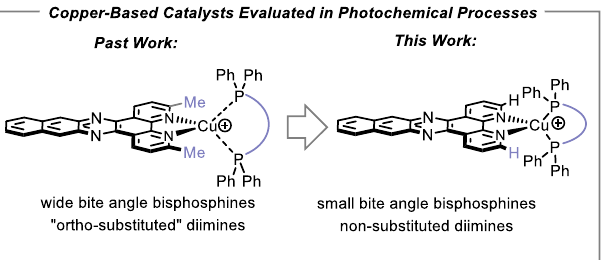
Figure 1. Small-bite-angle bisphosphine for heteroleptic copper-based complexes.